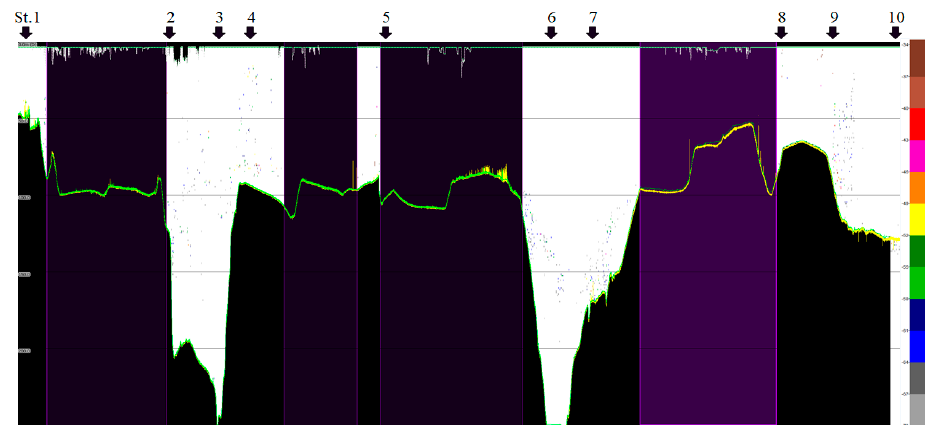
Figure 9. Vertical distribution of common squid.